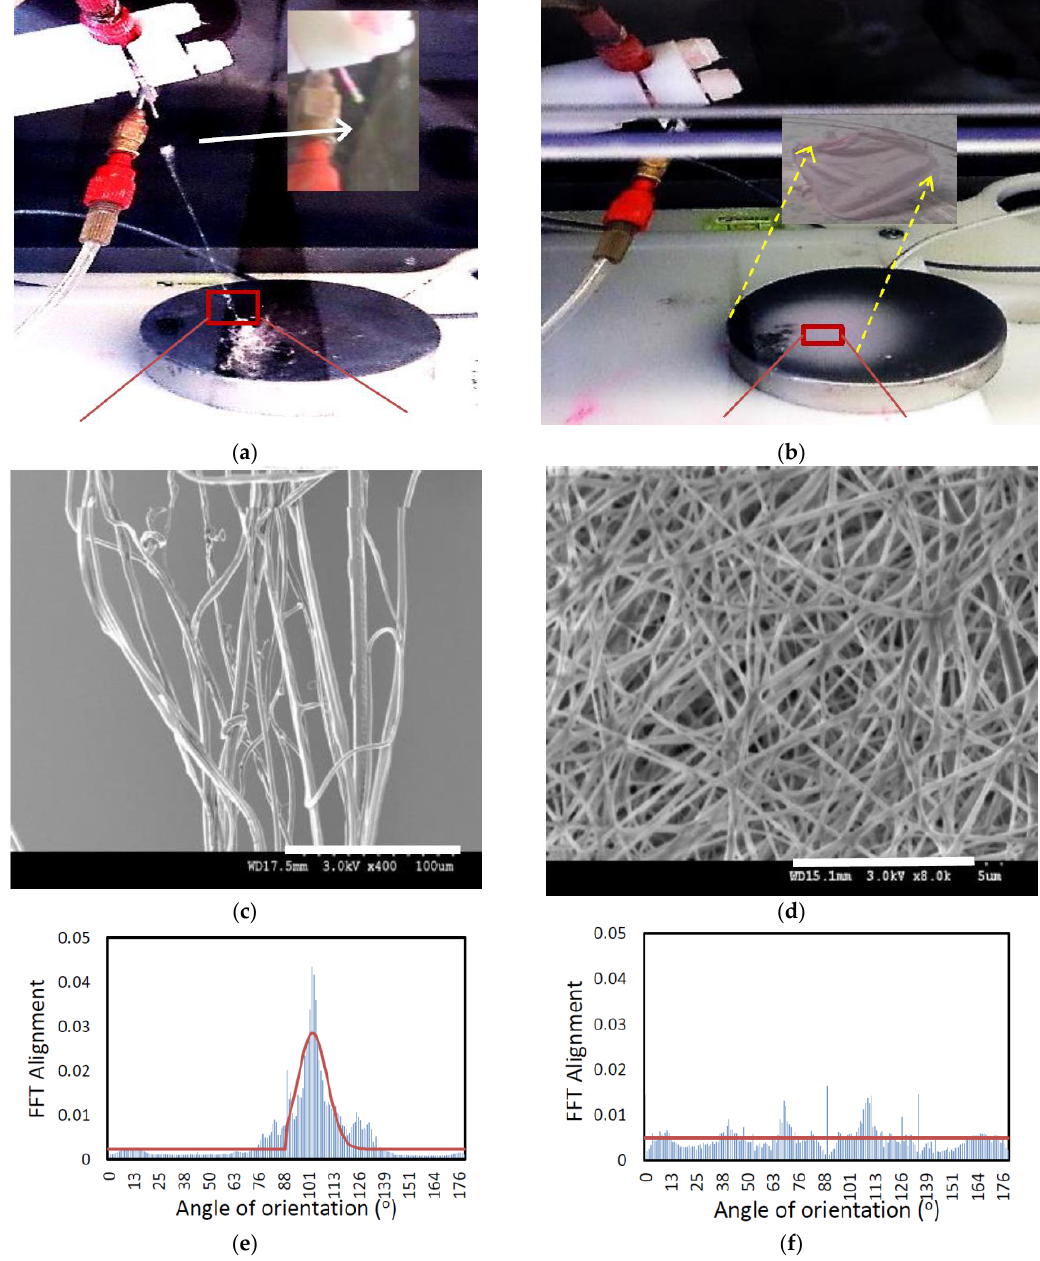
Figure 1. Fiber fabrication and characterizations that were formed in two applied voltage of 9 kV ( a , c , e ) and 18 kV ( b , d , f ); ( a ) a bunch of fibers aligned between the collector and the coaxial needle from the shell solution in light yellow color. ( b ) A random fiber orientation from the core solution in pink color. The morphology of the electrospun fibers applying ( c ) 9-kV voltage, ( d ) 18-kV voltage. ( e , f ) The directionality histogram reporting 2D-FFT alignment based on peak shape and the relative principle axis of orientation for the fibers that extracted from Image J raw output of FFT analysis of fibers corresponding to SEM images of c and d .